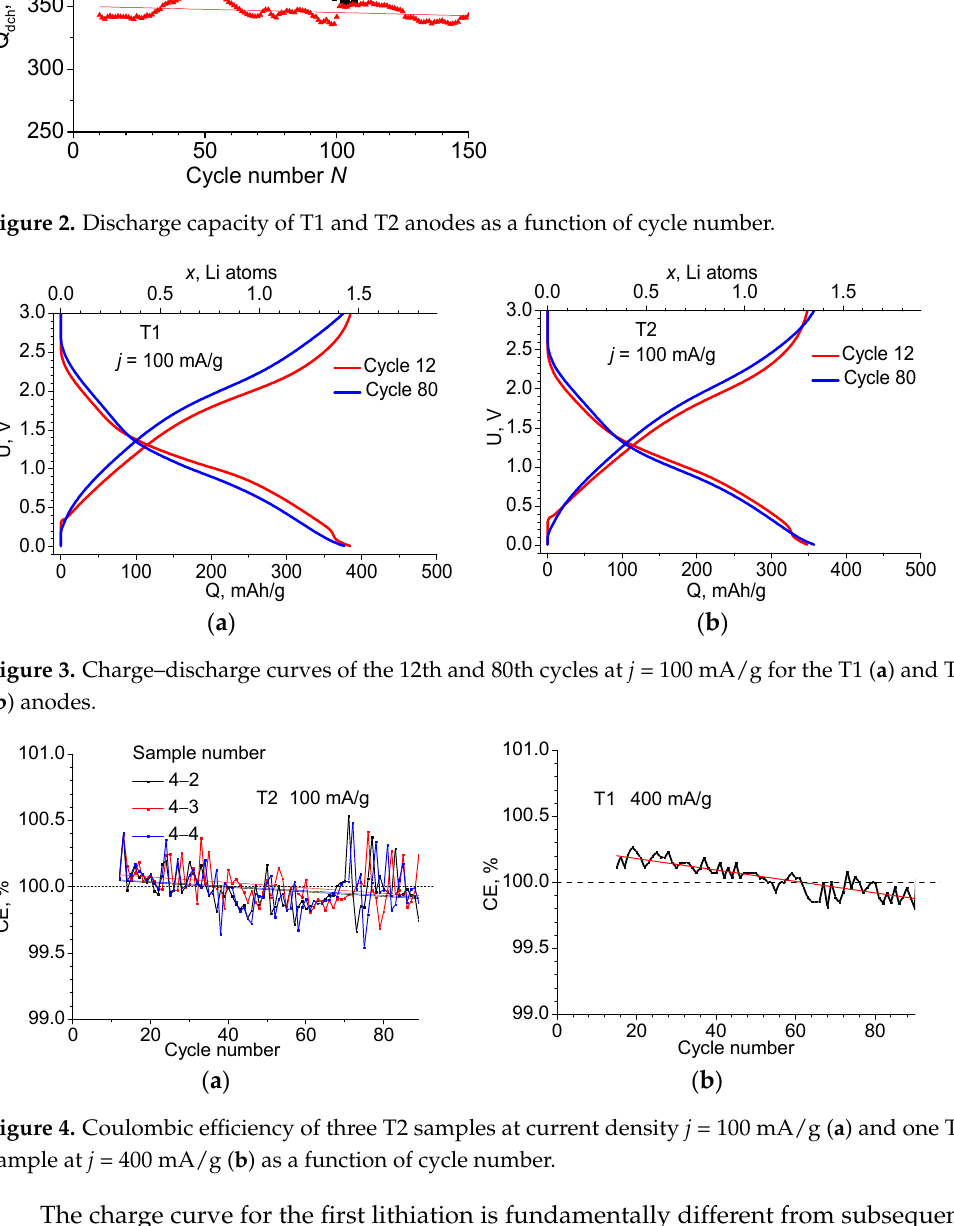
Figure 5. Dependencies of the discharge capacity on cycle number obtained with different charge–discharge currents shown in the figure: ( a ) for T1 and ( b ) for T2 materials (three samples of each). The charge curve for the first lithiation is fundamentally different from subsequent cycles (Figure 1). It has a long horizontal plateau which is characteristic of the materials forming two phases during lithiation. The position of this plateau is slightly different for the two materials: in the case of T1, it is higher with an average value of 0.82 V, and in the case of T2, with an average value of 0.74 V. Table 1 makes it possible to estimate the number of lithium g-atoms embedded in the different sections of the curve. The formula x = Q · M / F = 3.8 × 10 − 3 · Q , where M is the molar mass of TiOF 2 = 101.88 g/mol, Q in mAh/g, and F = 26,801 mAh/mol, was used for the calculation of lithium g-atoms number x per TiOF 2 mole. Table 1. Coordinates of characteristic points on charge and discharge curves of cycle 1 (Figure 1a), their corresponding amount of embedded or extracted lithium x , and its increment Δ x at each step. U , V Q , mAh/g